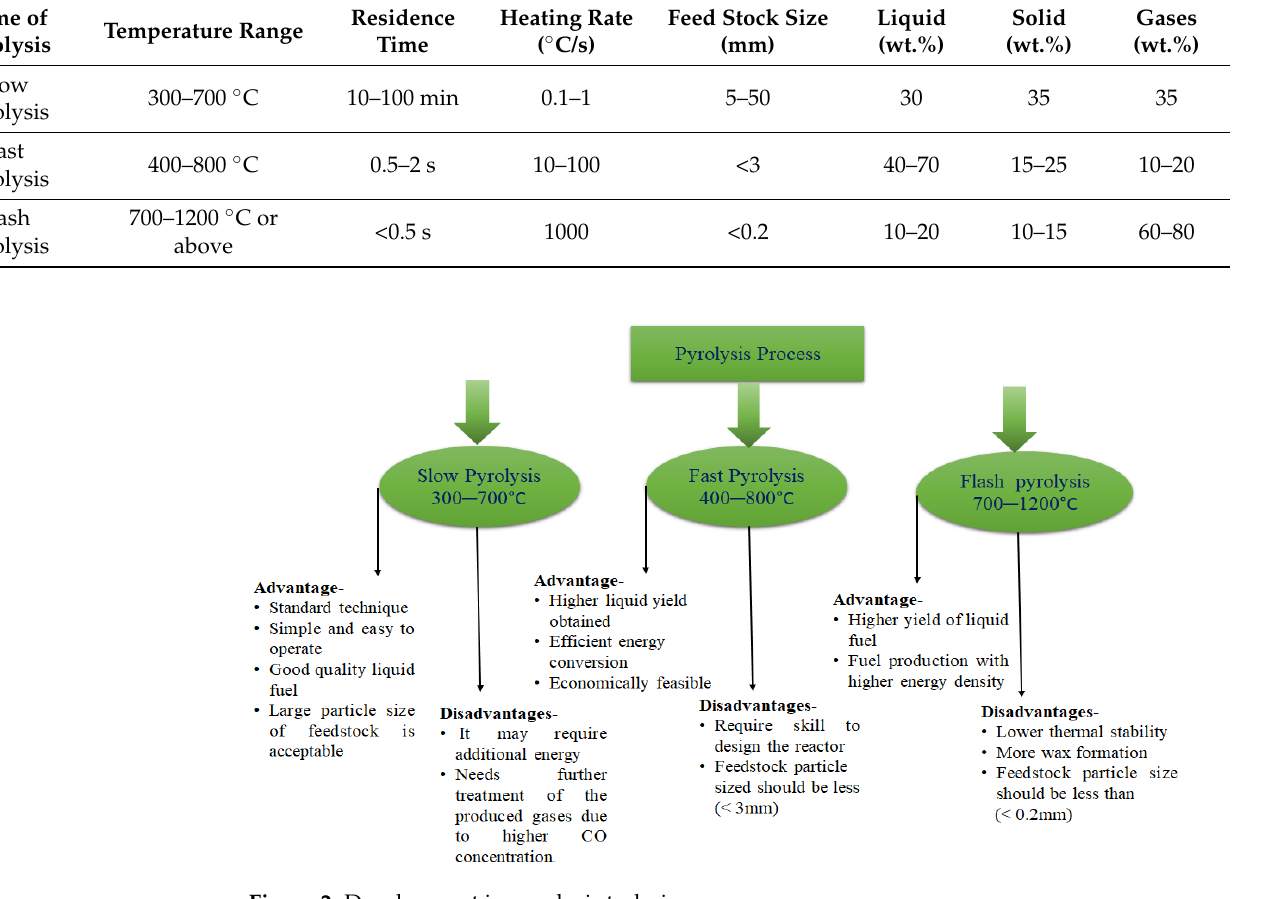
Figure 2. Development in pyrolysis technique.